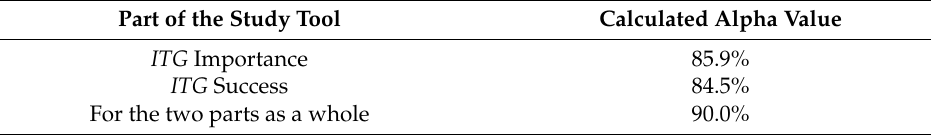
Table 1. The degree of reliability of the study tool. Part of the Study Tool Calculated Alpha Value ITG